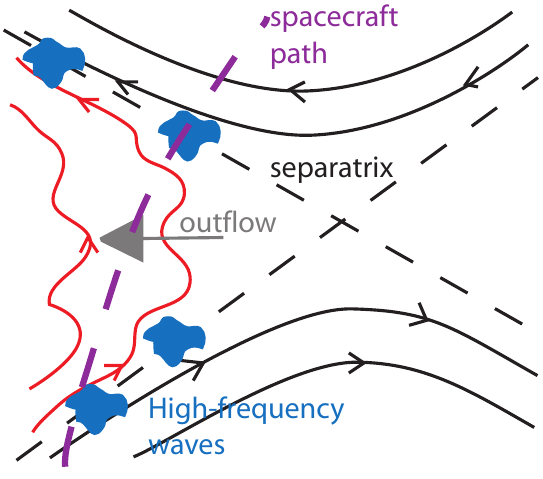
Fig. 5. Schematic of a reconnection region crossing by a